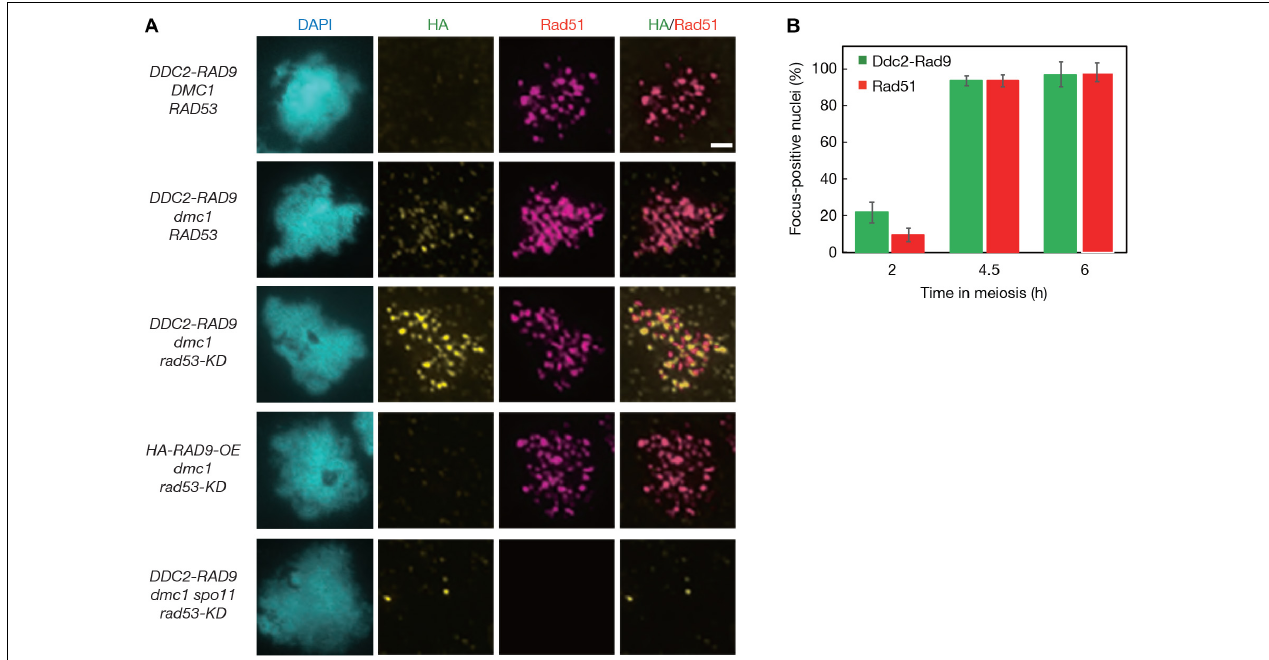
FIGURE 3 | Ddc2-Rad9 localizes to meiotic DSBs. (A) The representative images of anti-HA and anti-Rad51 double immunostaining of spread nuclei prepared from DDC2-RAD9 (USY544/671), DDC2-RAD9 dmc1 RAD53 (USY580/591), DDC2-RAD9 dmc1 rad53-KD (USY582/623), HA-RAD9-OE dmc1 rad53-KD (USY582/674), and DDC2-RAD9 dmc1 spo11 rad53-KD (USY559/666) strains are shown at 4.5 h in meiosis, except for DDC2-RAD9 dmc1 RAD53 , which is shown at 6 h in meiosis. Typical DNA images stained with DAPI and merged images by HA- and Rad51-staining are presented. Bar equals 2 µ m. (B) The percentage of dmc1 (cid:49) rad53-KD DDC2-RAD9 nuclei that had more than 5 HA or Rad51 staining foci is presented at the indicated time points. At least 50 nuclei were counted at each time point. Error bars represent standard deviations obtained from 3 independent time courses.